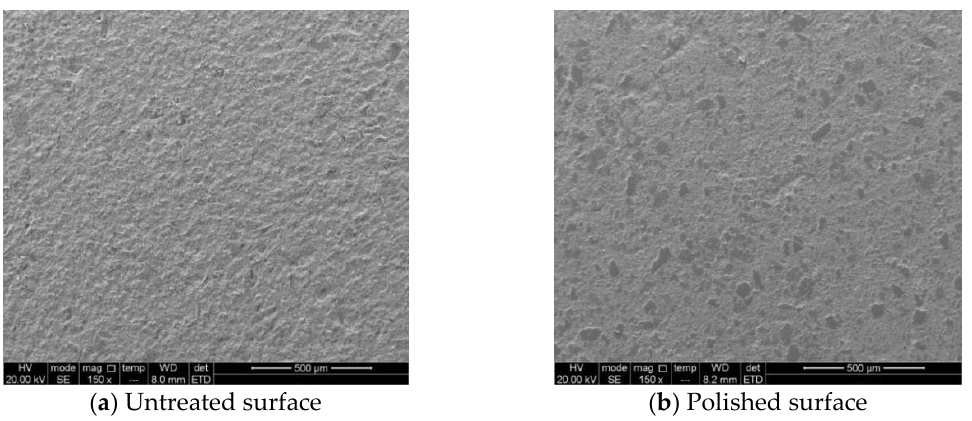
Figure 1. The images of shale surface treatment.